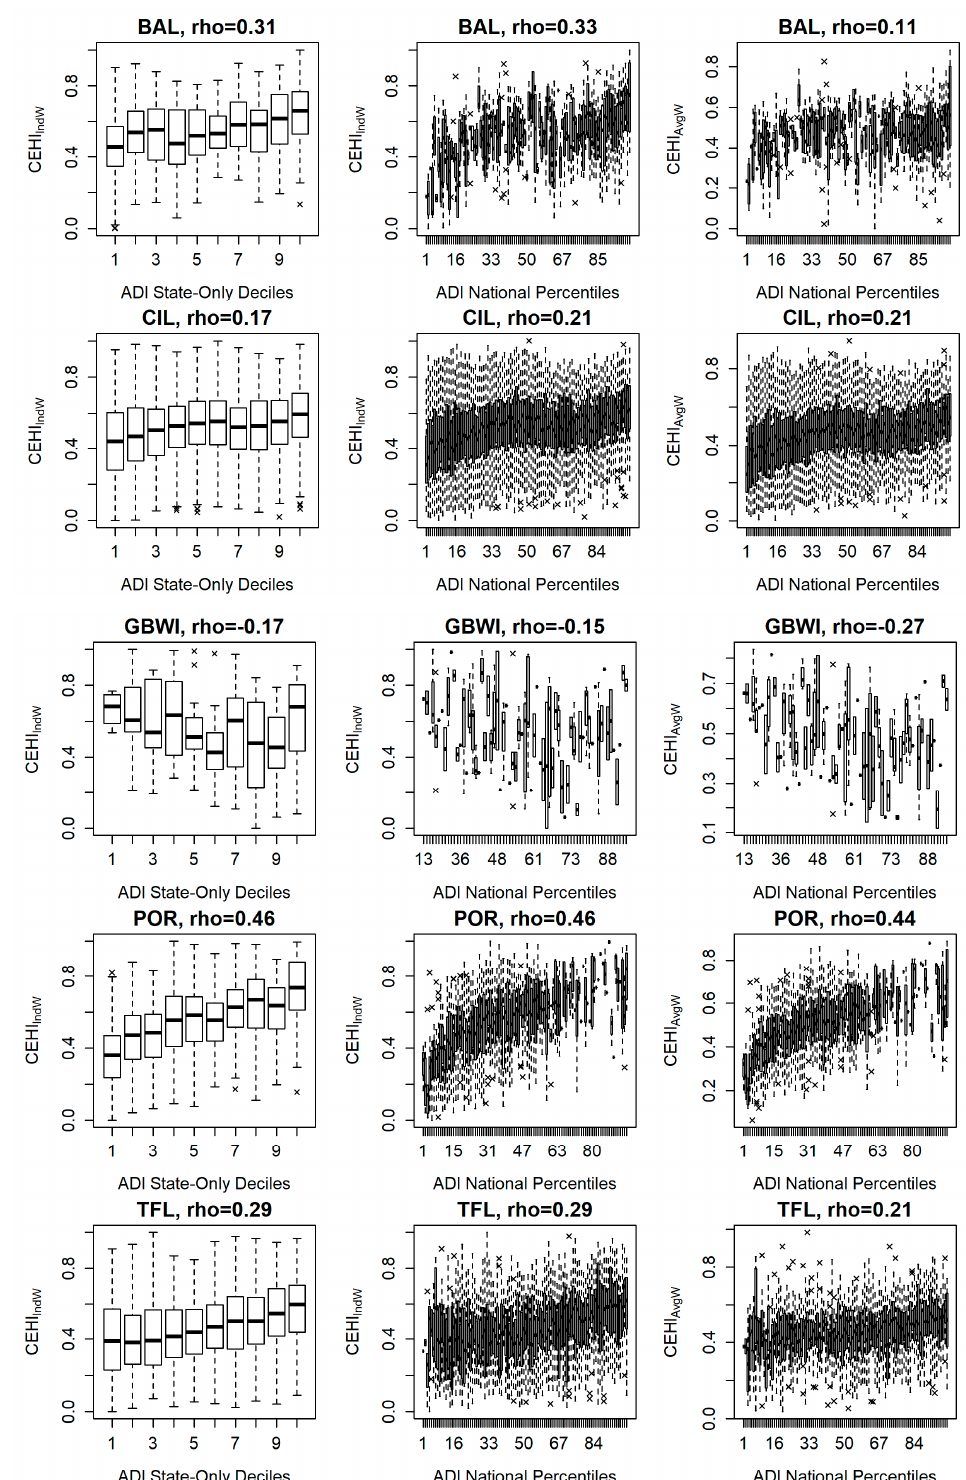
Figure 5. Spearman correlations (rho, ρ ) of CEHI IndW and ADI state-only deciles (first column), CEHI IndW and ADI national percentiles (second column), and CEHI AvgW and ADI national percentiles (third column) across CBGs in Birmingham, AL (BAL), Chicago, IL (CIL), Green Bay, WI (GBWI), Portland, OR (POR), and Tampa, FL (TFL). All correlations are significant ( p < 0.05), except for the plot relating GBWI CEHI IndW and ADI national percentiles ( p < 0.1).